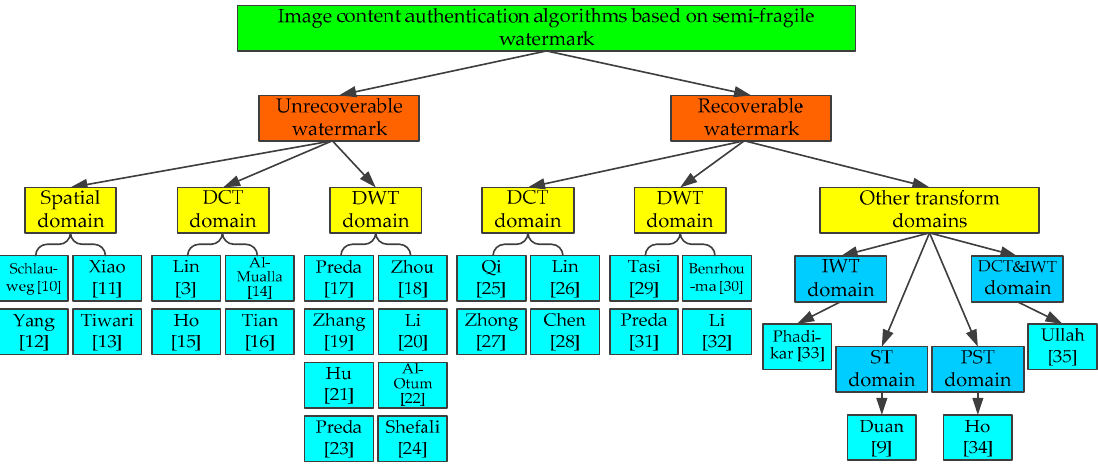
Figure 3. Image content authentication algorithms based on semi-fragile watermark.